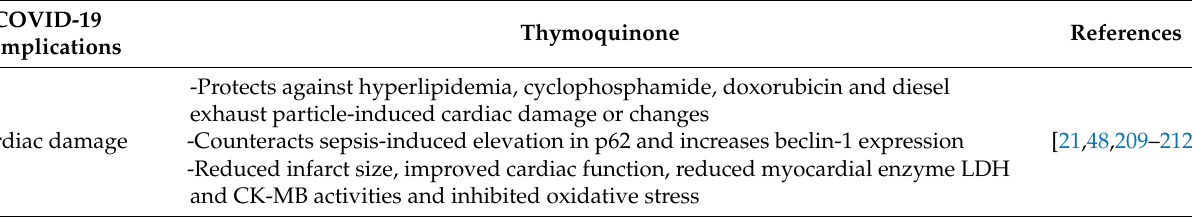
Table 4. The beneficial effects of TQ against COVID-19 pathophysiological